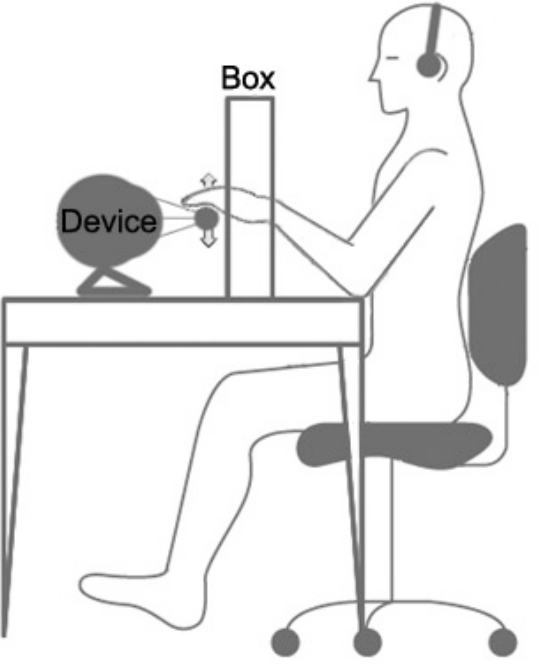
Figure 2. Experimental setup. The subject wears headphones (to avoid hearing the motors of the haptic device) while the box in front of the subject prevents from seeing the haptic